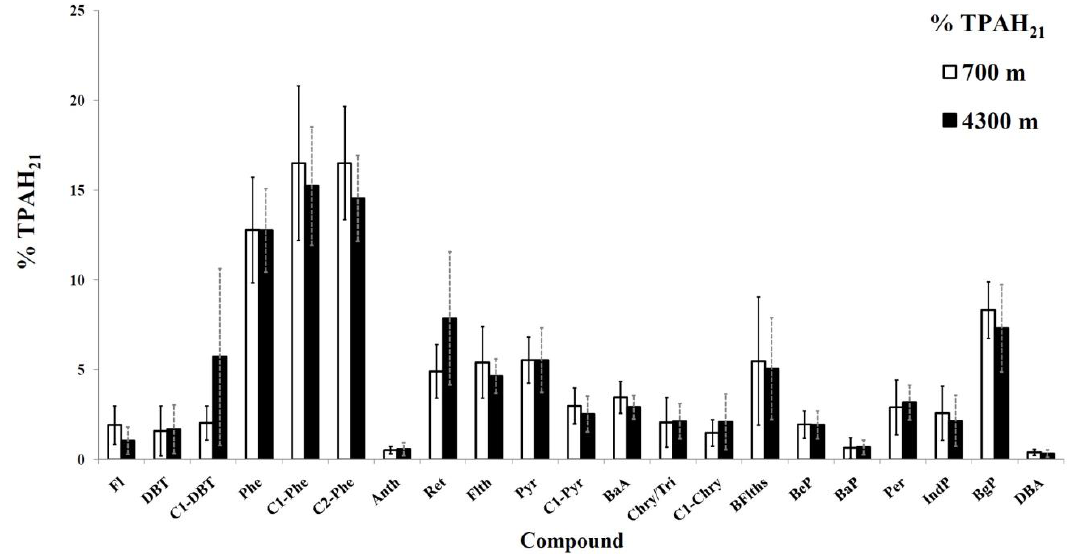
Fig. 4. Molecular profile of PAHs in sinking particles at 700m and 4300m depth with mean abundances normalized as percentage of the total sum of PAHs monitored (TPAH 21 ) and standard errors. PAH abbreviations: Fluorene ( Fl ); dibenzothiophene ( DBT ); methyldibenzothiophenes ( C 1 -DBT ); phenanthrene ( Phe) ; methylphenanthrenes ( C 1 -Phe) ; dimethylphenanthrenes ( C 2 -Phe ); anthracene ( Anth ); retene ( Ret ); fluoranthene ( Flth ); pyrene ( Pyr ); methylpyrenes ( C 1 -Pyr ); benz[ a ]anthracene ( BaA ); chrysene/triphenylene ( Chry/Tri ); methylchrysenes ( C 1 -Chry ); benzo[ b/j/k ]fluoranthene ( BFlths ); benzo[ e ]pyrene ( BeP ); benzo[ a ]pyrene ( BaP ); perylene ( Per ); indeno[1,2,3- cd